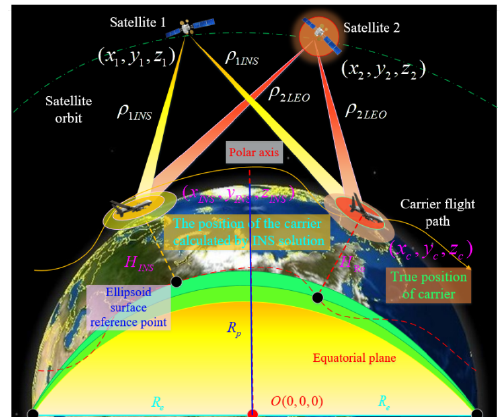
Figure 2. Standard INS + LEO2 + altimeter integrated navigation and positioning principle